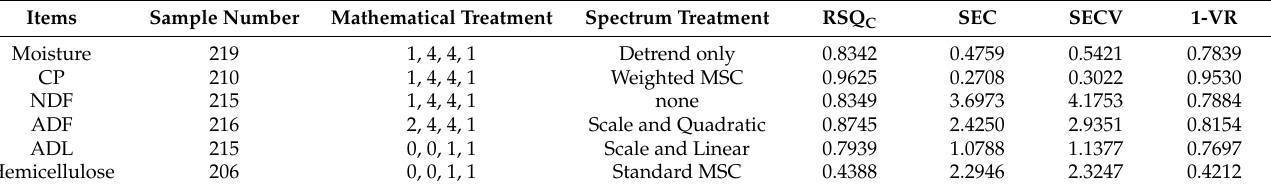
Table 6. Optimal NIRS prediction models of straw